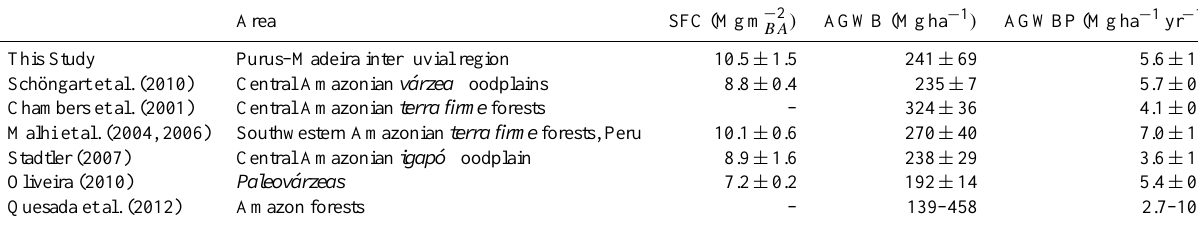
Table 6. Comparison between estimates of AGWB (in Mgha − 1 ) and AGWBP (in Mgha − 1 yr − 1 ) of old-growth forests from this study, with estimates from nutrient-rich ( várzea ) and nutrient-poor ( igapó ) floodplain forests, and non-flooded sites ( paleovárzeas on ancient fluvial terraces and terra firme ). The studies of Stadtler (2007), Oliveira (2010) and Schöngart et al. (2010) applied for the estimates of AGWB and AGWBP allometric models considering three independent parameters (diameter, tree height and wood density), while Chambers et al. (2001) and Malhi et al. (2004, 2006) use allometric models with only one (diameter) and two independent variables (diameter, wood ) is the structural conversion factor relating AGWB to 1 square meter basal area (BA). Values are density), respectively. SFC (in Mgm − 2 BA presented as means and standard deviation (with exception of those from Quesada et al., 2012). The results of other studies presented as Mg C were doubled to correspond to wood